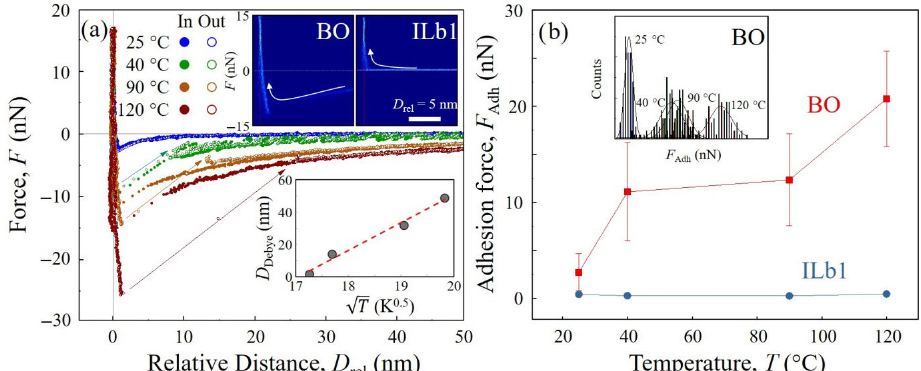
Fig. 3 Comparison of the AFM F–D characteristics of BO and ILb1 between a gold-coated AFM cantilever and a smooth iron thin film sputtered on mica under controlled temperatures. (a) Representative AFM F–D approach (solid circle) and retraction (hollow circle) curves of BO at 25, 40, 90, and 120 °C. The insets (top right) show the probability mappings (> 50 curves) of the F–D profile of BO and ILb1 at 90 °C (operating temperature). (b) Adhesion force between the tip and iron surface with the presence of BO and ILb1 under tested temperatures. The inset shows an example histogram of the measured adhesive events from BO, where the distributions were fitted using normal Gaussian